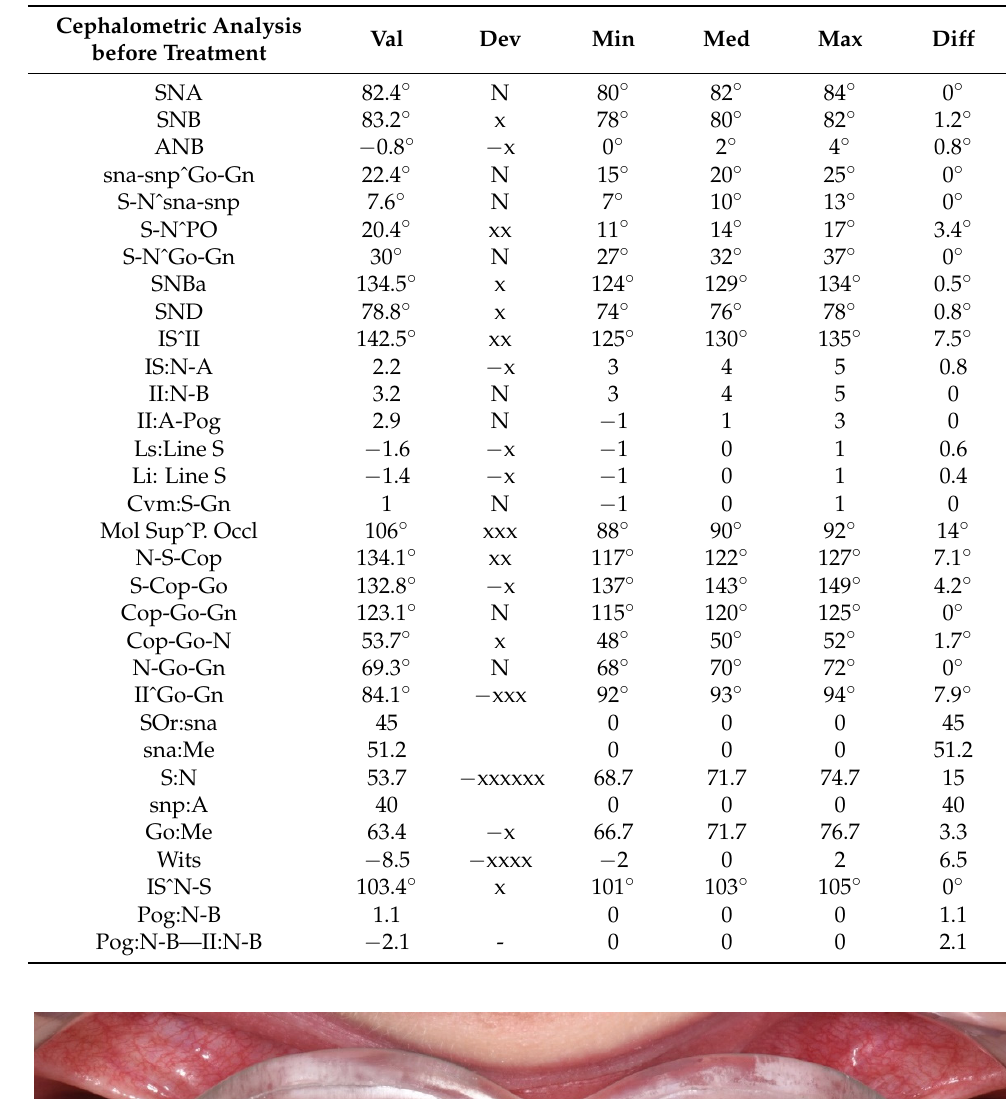
Table 3. Cephalometric analysis before treatment.